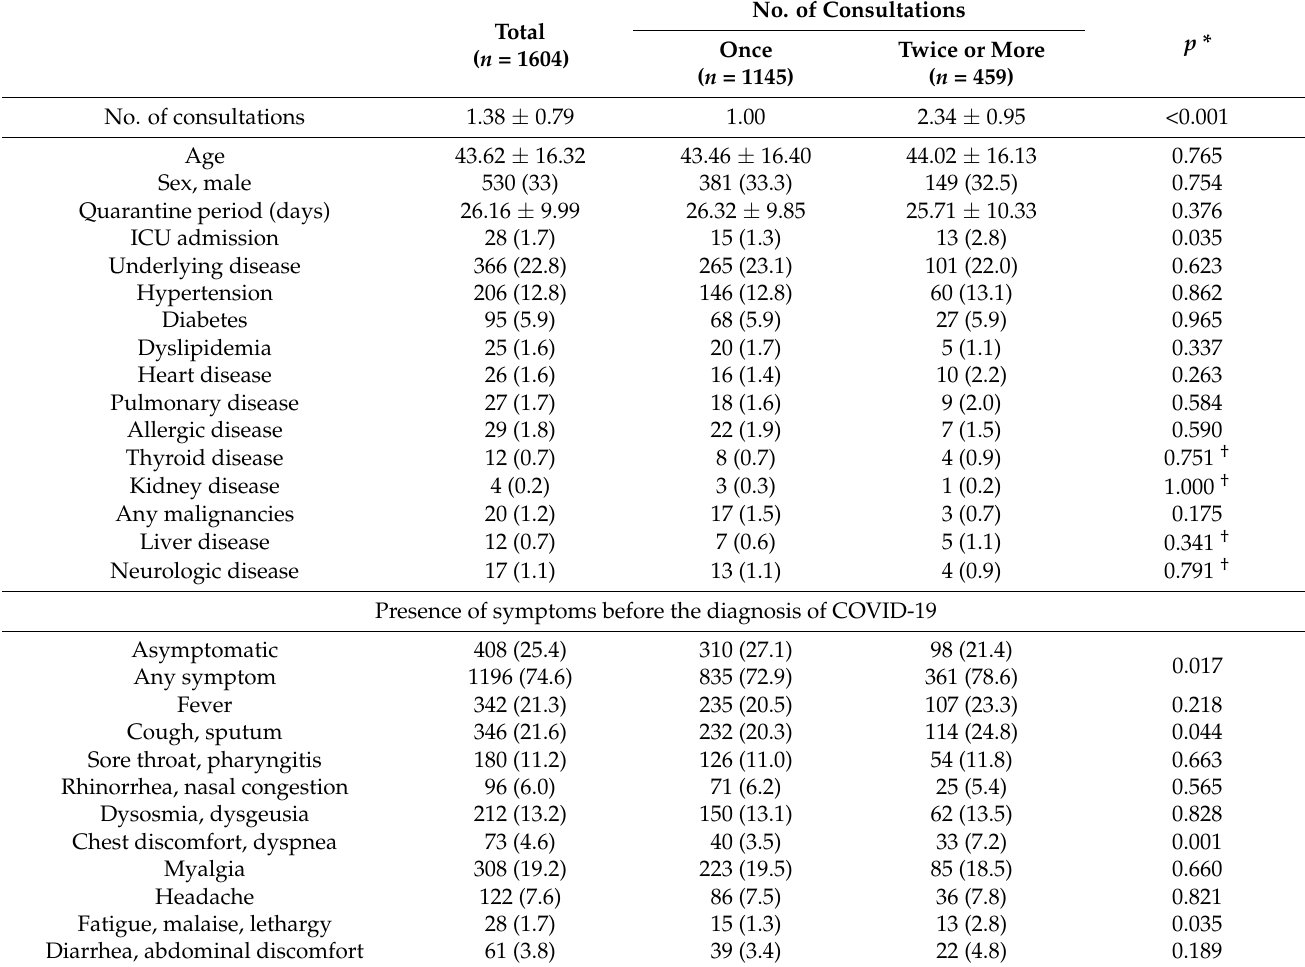
Table 1. Clinical characteristics of the subjects during and before infection with